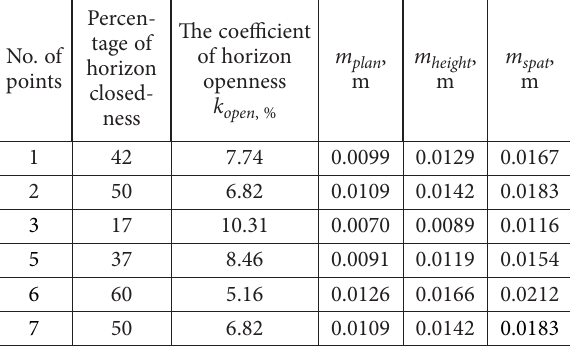
Table 1. Received values of RMSE of spatial m spat , planned m plan and height m height location of points